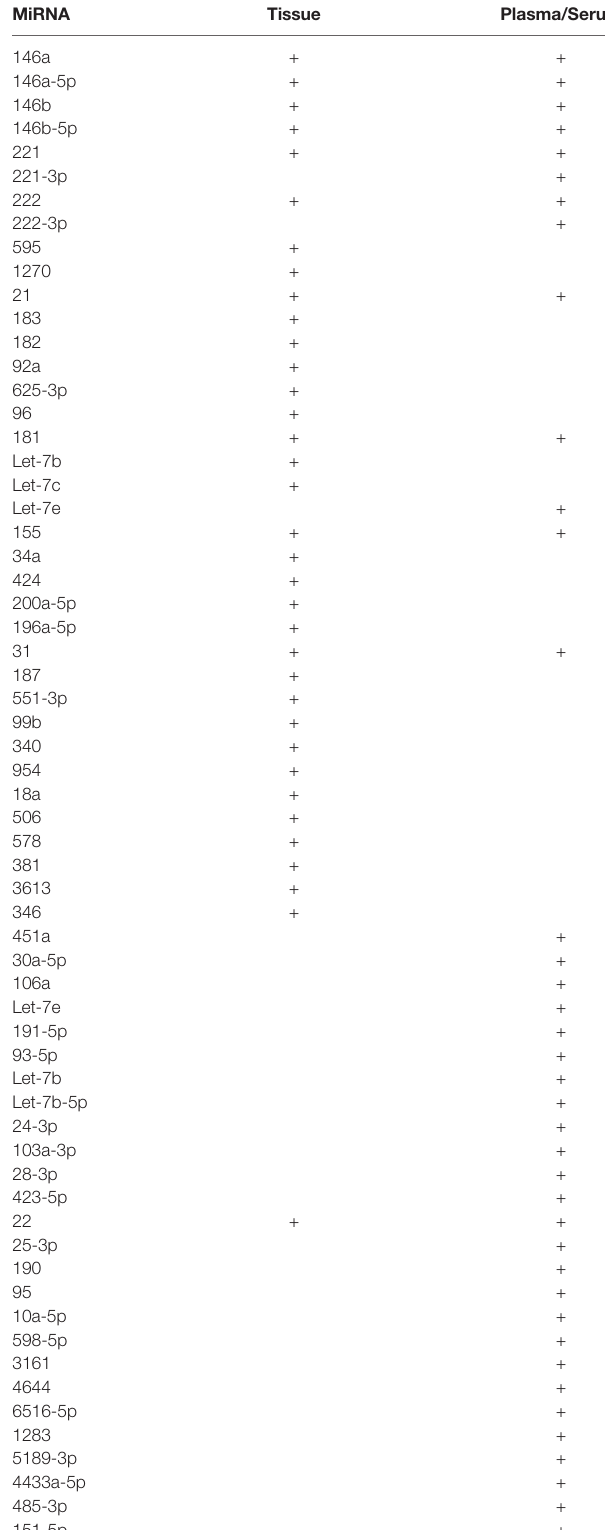
TABLE 1 | Upregulated miRNA in papillary thyroid